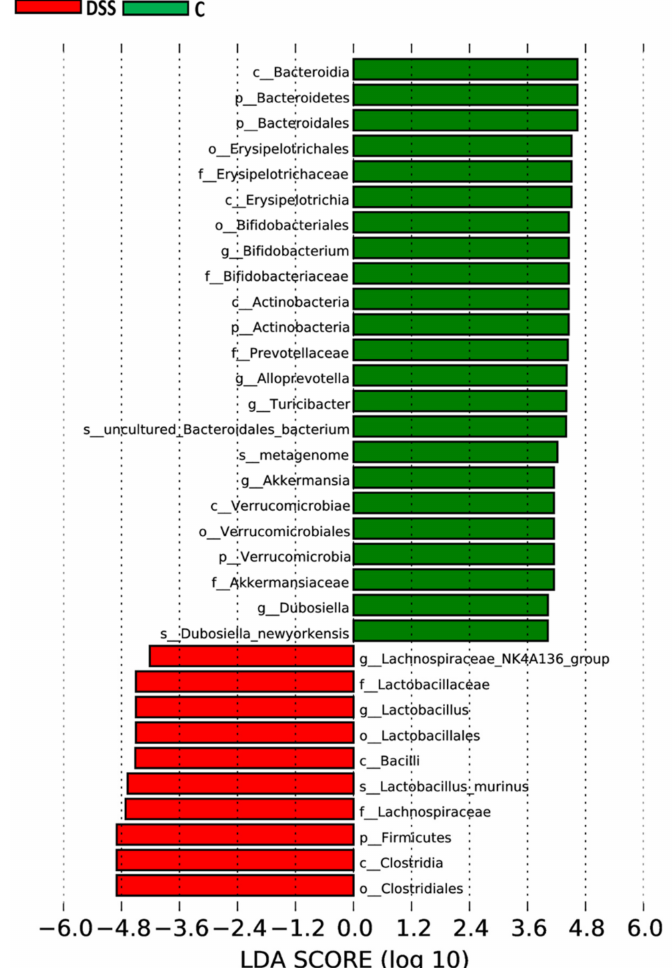
Figure 10. Histogram of LDA scores. Horizontal bars represent the effect size for each taxon. The length of the bar represents the log 10 transformed LDA score, indicated by vertical dotted